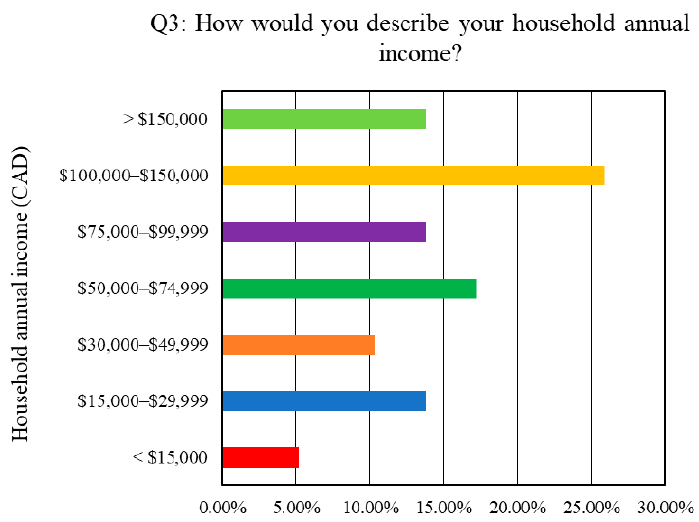
Figure 4. Participants’ annual income (amounts are in Canadian dollars).